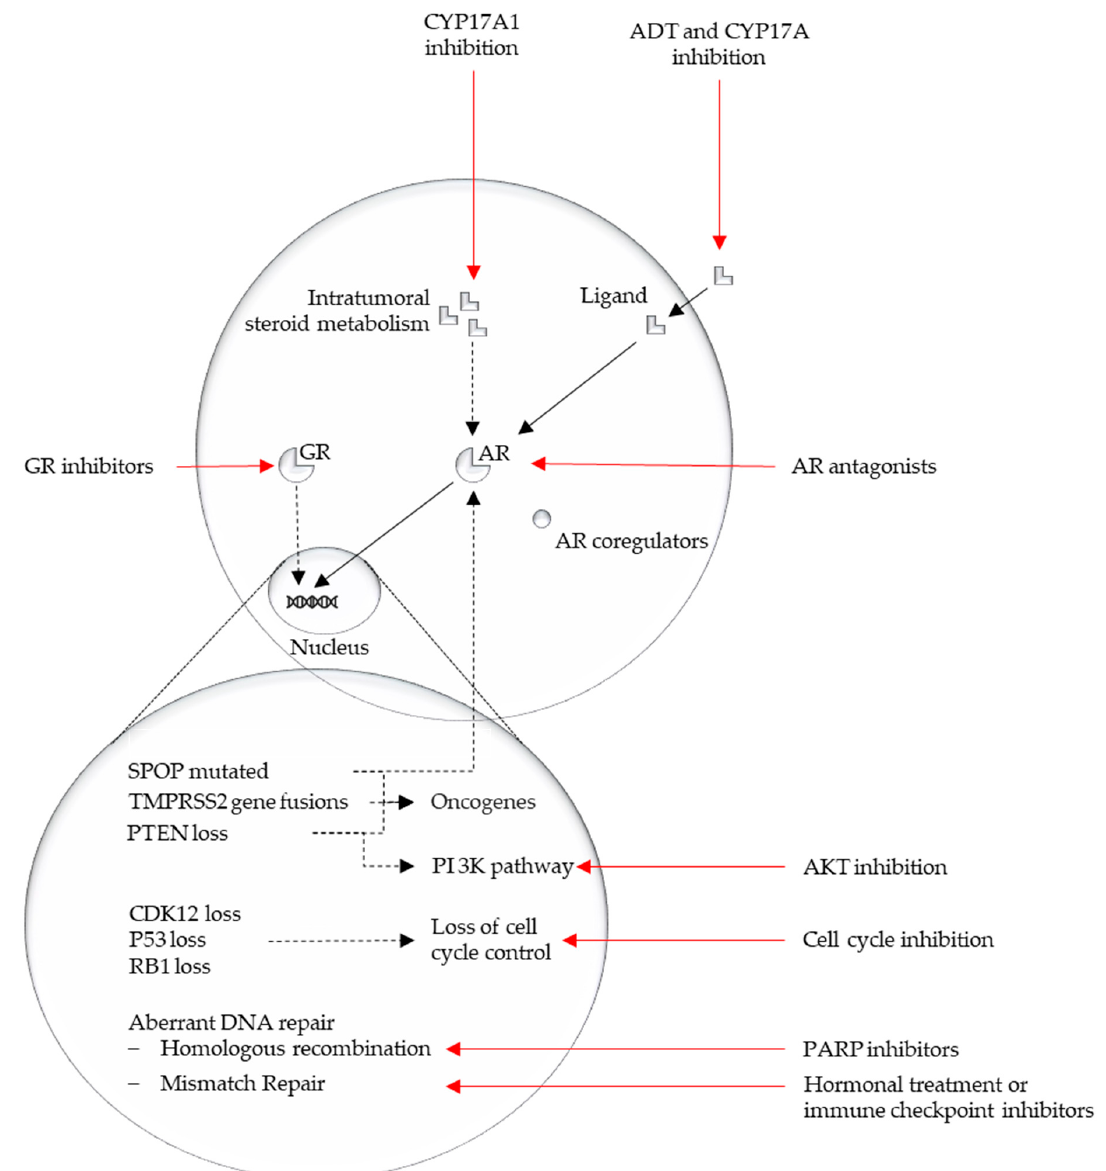
Figure 2. Overview major affected pathways in mCRPC and their possible actionability.